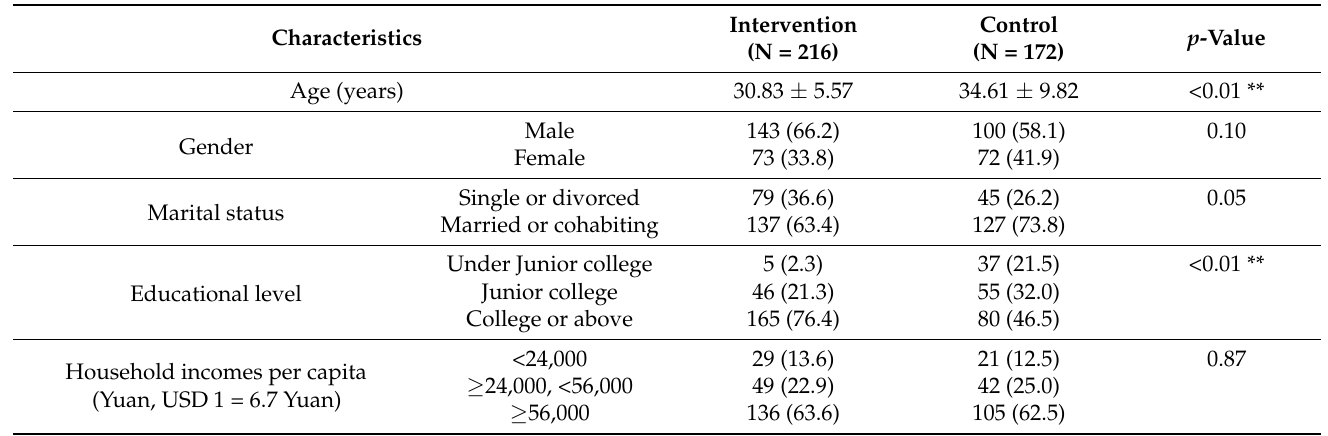
Table 1. Characteristics of the study participants at the baseline.